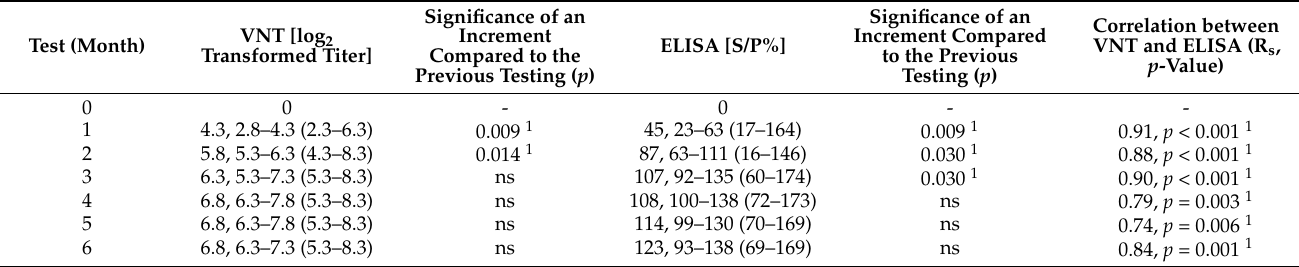
Table 1. Antibody titers in virus neutralization test (VNT) and sample-to-positive control ratio in ELISA during 12 months